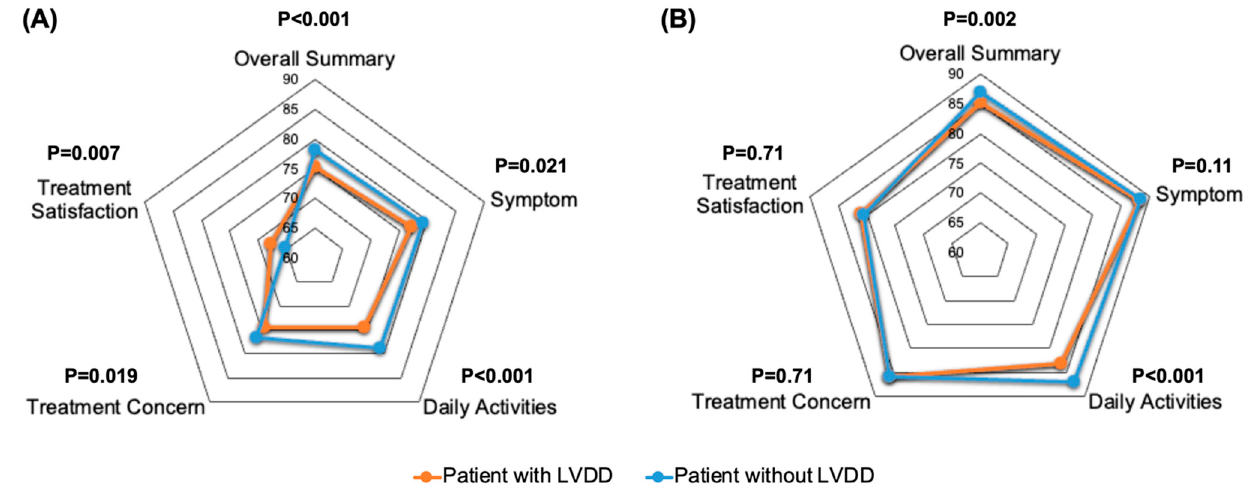
Figure 3. The Atrial Fibrillation Effects on QualiTy-of-Life outcomes at baseline and 1-year follow-up. Comparison of the Atrial Fibrillation Effects on QualiTy-of-Life overall summary score and individual